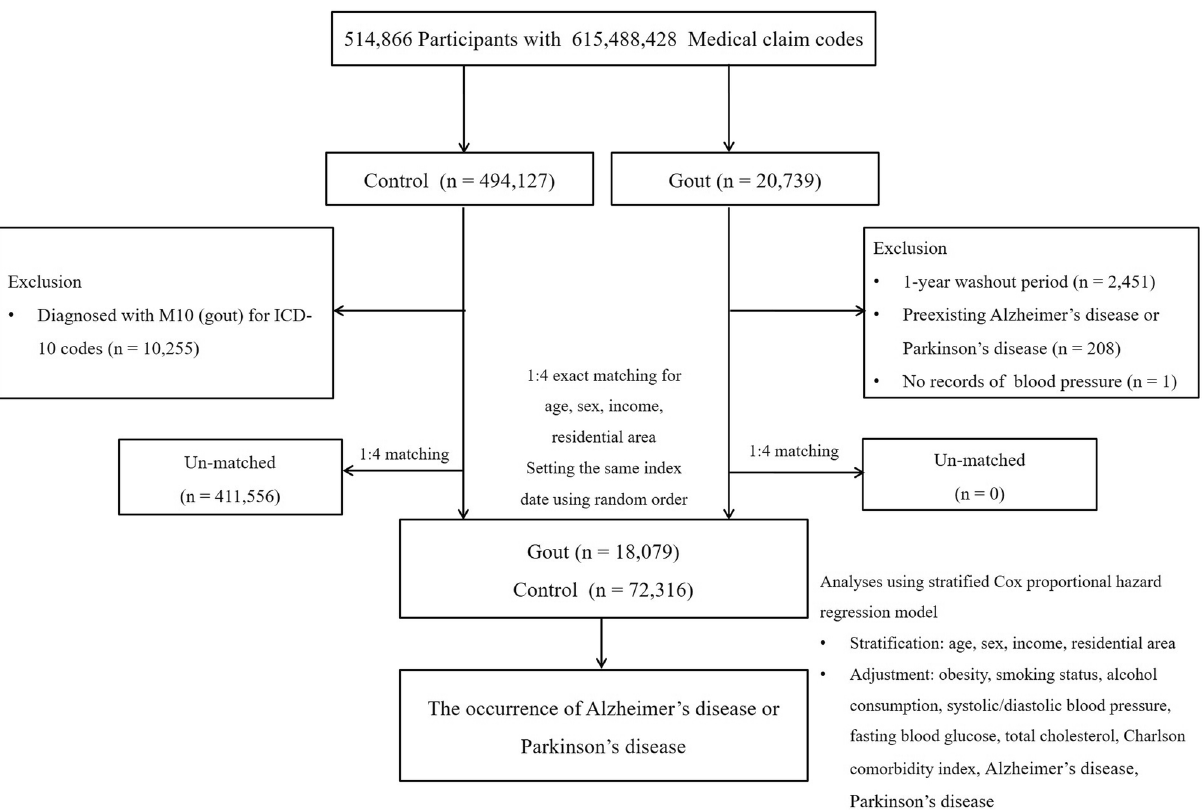
72,316 control participants without gout were matched at a 1:4 ratio on age, sex, income, and residential